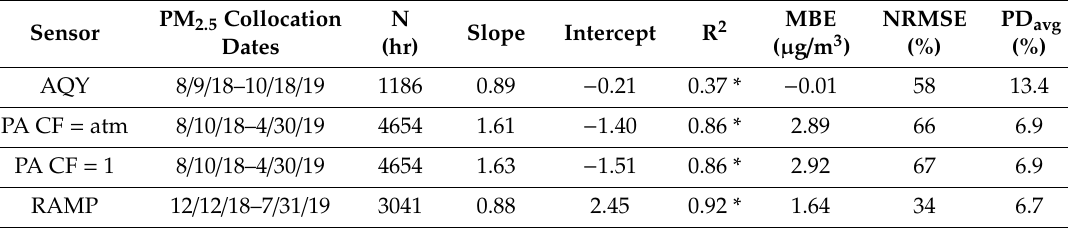
Table 4. Average PM 2.5 linear regression parameters a for 2 sensors of each type at AIRS during ambient